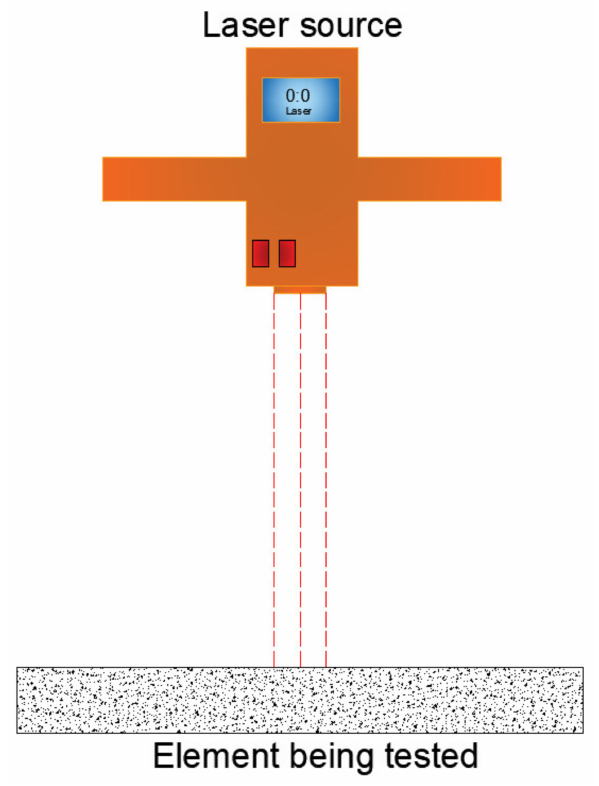
Figure 10. Laser monitoring